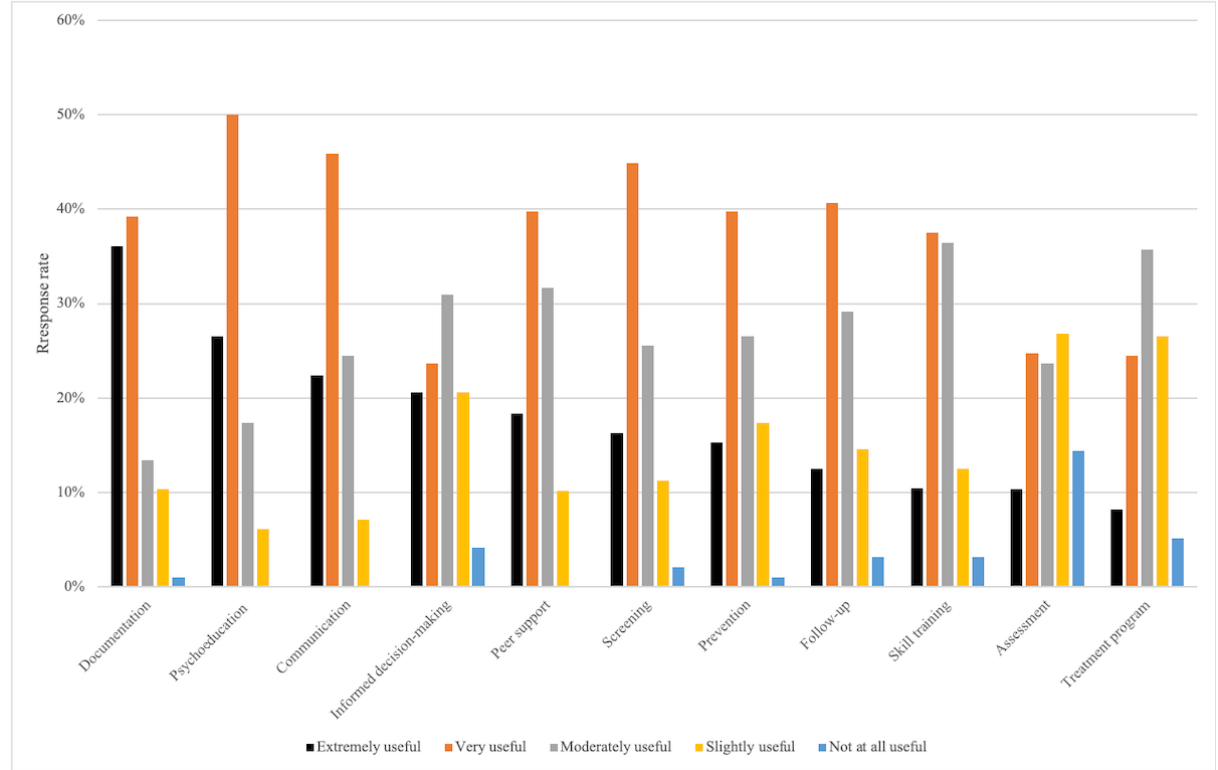
Figure 1. Perceived importance of certain applications of web-based mental health resources.